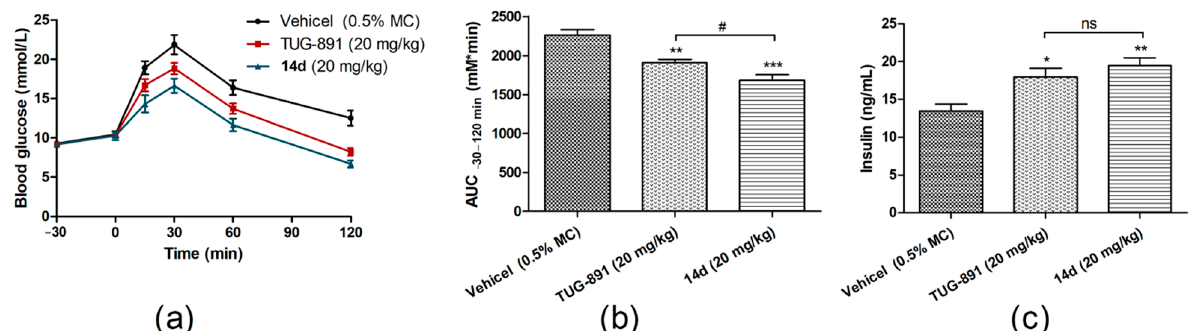
Figure 4. Effects of compound 14d and TUG-891 on plasma glucose levels during the OGTT in fasting DIO mice. ( a ) The changes of blood glucose levels after oral administration of compound 14d , followed by the oral glucose load (2 g/kg); ( b ) AUC − 30–120 min of plasma glucose levels. ( c ) Insulin levels at 30 min after the glucose load. Values are expressed as the mean ± SD ( n = 6). * p ≤ 0.05 compared with vehicle-treated DIO mice by Student’s t test; ** p ≤ 0.01 compared with vehicle-treated DIO mice by Student’s t test; *** p ≤ 0.001 compared with vehicle-treated DIO mice by Student’s t test; # p ≤ 0.05 compared with TUG-891-treated DIO mice by Student’s t test; ns means no significant.